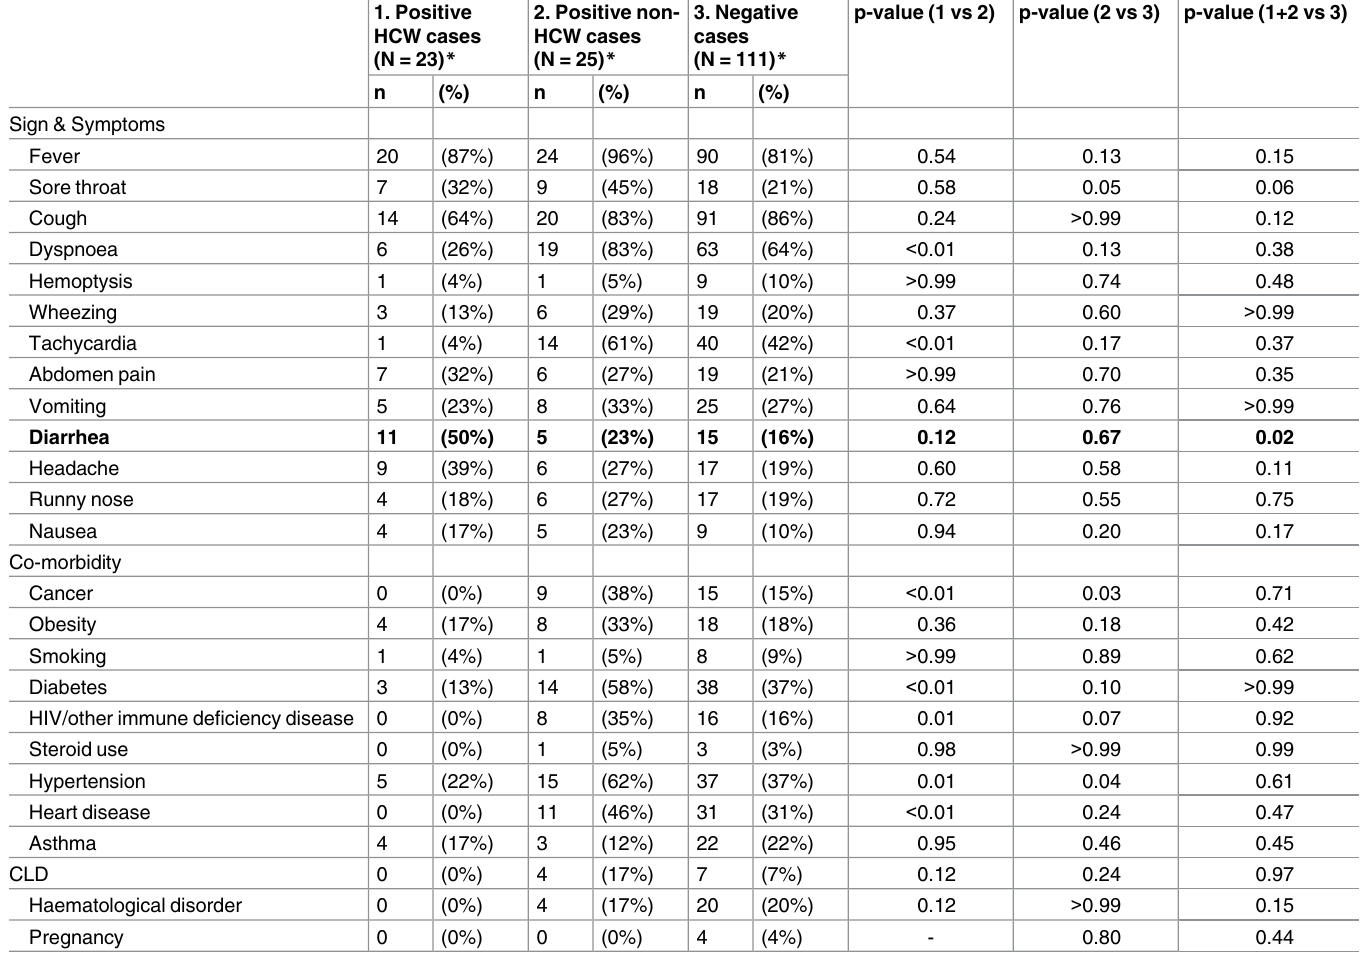
Table 3. Comparison of clinical symptoms and co-morbidity status among the three patient